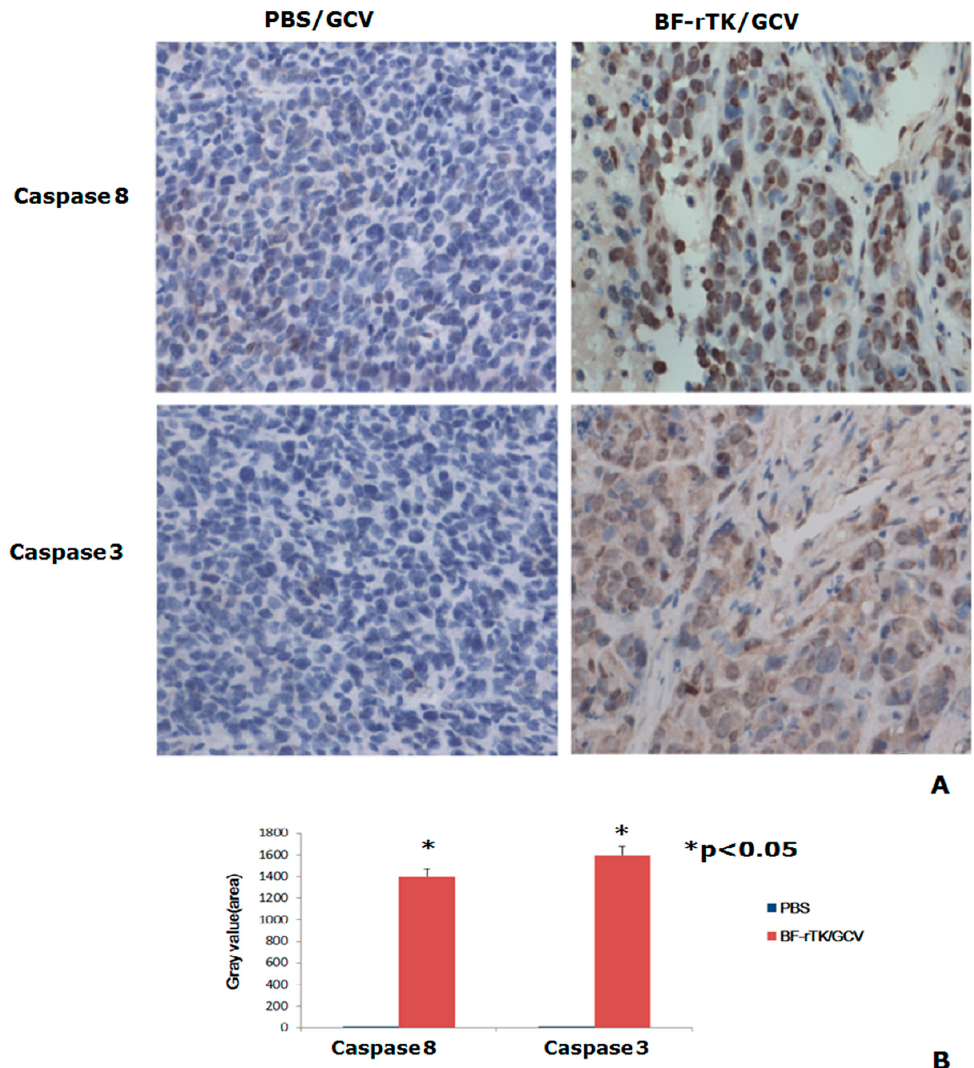
Figure 7. IHC assay of the intestinal cancer colo320 xenograft sample from nude mice treated by BF-rTK/GCV ( n = 3). ( A ) The tumor tissue samples were from intestinal cancer colo320 cells treated by PBS/GCV, and BF-rTK/GCV, respectively. The caspase 8 and caspase 3 levels were analyzed with IHC; ( B ) Quantitative analysis of caspase 8 and caspase 3 (* p < 0.05).